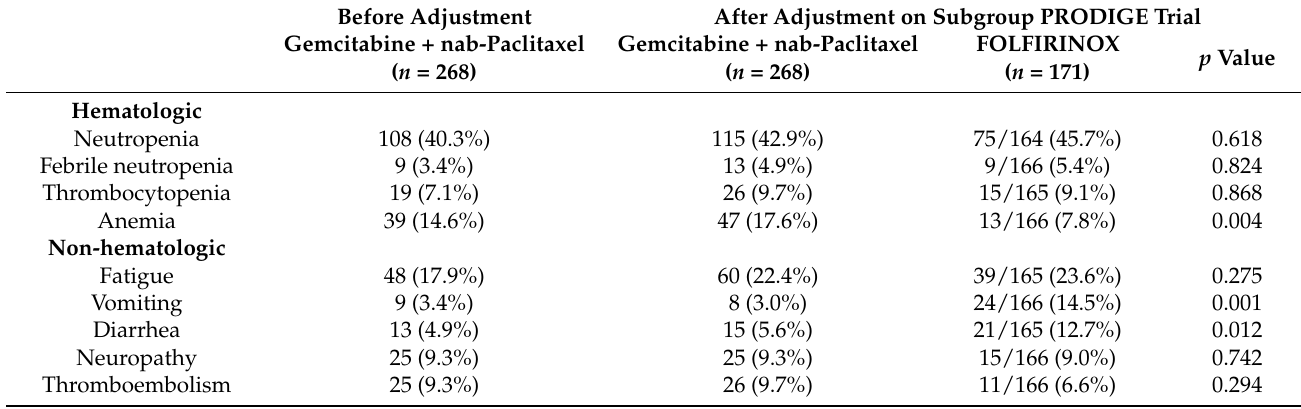
Table 2. Most common grade 3 or 4 adverse events in patients receiving gemcitabine + nab-paclitaxel for metastatic pancreatic cancer before and after adjustment to balance the PRODIGE trial.